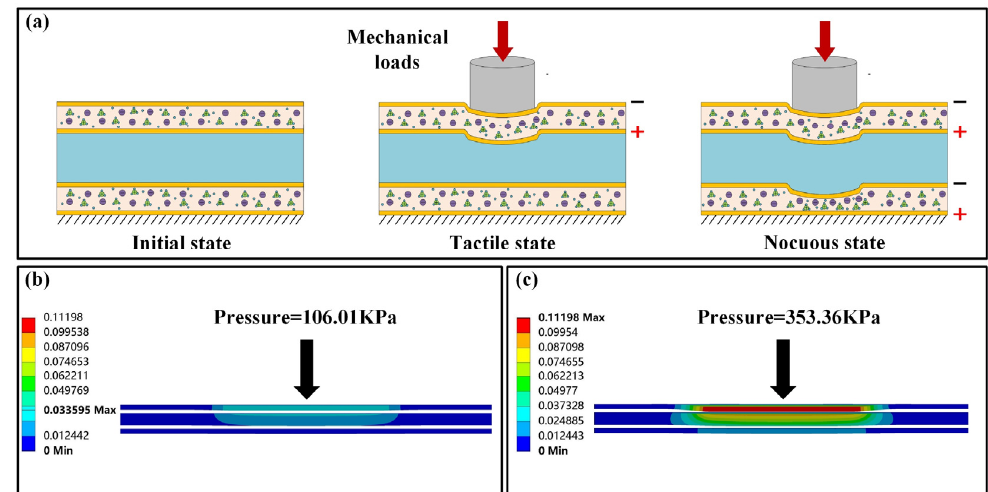
Figure 5. Working mechanism of the bio − inspired artificial receptor under mechanical stimuli with different amplitude. ( a ) Schematic of bio − inspired artificial receptor in different phases of operation. ( b ) The deformation distribution cloud diagram of the top IPMC layer, PDMS layer and bottom IPMC layer when load is 106.01 kPa. ( c ) The deformation distribution cloud diagram of the top IPMC layer, PDMS layer and bottom IPMC layer when load is 353.36 kPa.